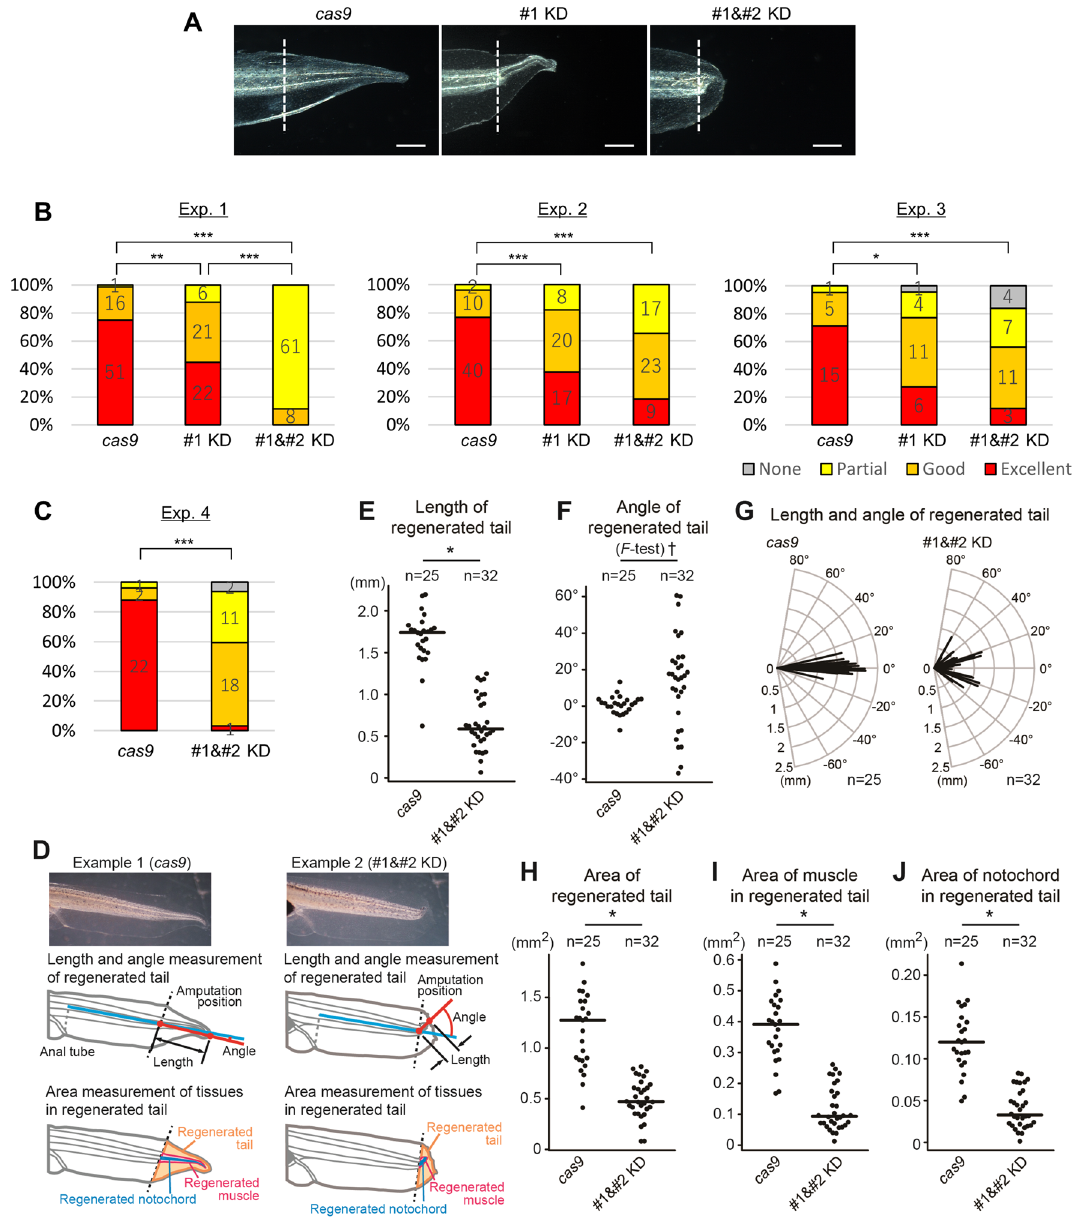
Figure 2. il11ra.L is required for X. laevis tadpole tail regeneration. ( A ) Typical examples of regenerated tails at 7 dpa of tadpoles injected with either (left) cas9 mRNA only, (center) cas9 mRNA and guide RNA #1, or (right) cas9 mRNA, and guide RNA #1 and #2. Dashed lines indicate the amputation site. Scale bars: 500 µm. ( B ) Regeneration outcomes of il11ra.L KD tadpoles. Tadpoles at 7 dpa were classified into 4 groups depending on their tail regeneration: Excellent, completely regenerated with all tissues; Good, with all tissues but short or bent tail; Partial, with tissue(s) defect; None, no regeneration. Numbers shown in the bar chart are numbers of tadpoles classified into each group. Statistical significance was assessed by Fisher’s exact test with the Benjamini–Hochberg method, * P < 0.05, ** P < 0.01, *** P < 0.001. ( C – J ) Measurement of regenerated tails. ( C ) Regeneration outcomes of the KD experiment used for measurement. The same classification criteria as in ( B ) were used. cas9 group, n = 25; #1&#2 KD group, n = 32. *** P < 0.001 by Fisher’s exact test. ( D ) Schematic figure of the measurement. ( E ) Length of the regenerated tails. Bars indicate means. * P < 1 × 10 –10 by Welch’s t -test. ( F ) Axis angle of the regenerated tails. The dispersion in the 2 groups was compared by F -test, † P < 1 × 10 –10 . ( G ) Combined plot of length and axis angle of the regenerated tails. ( H – J ) Measured area of ( H ) whole regenerated tail, ( I ) muscle and ( J ) notochord in the regenerated tail. Bars indicate means. * P < 1 × 10 –9 by Welch’s t